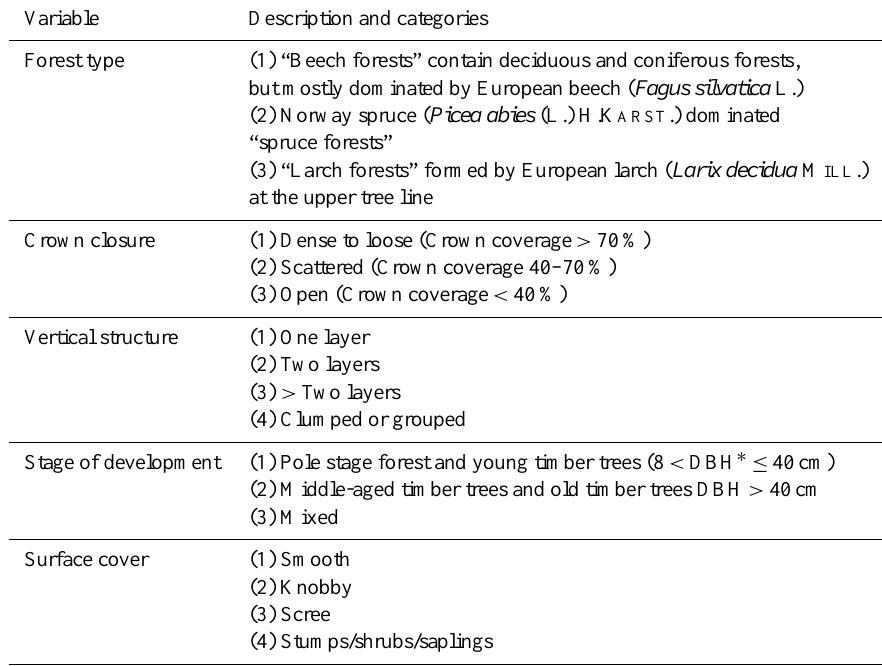
Table 1. Forest parameters and corresponding categories assigned to each